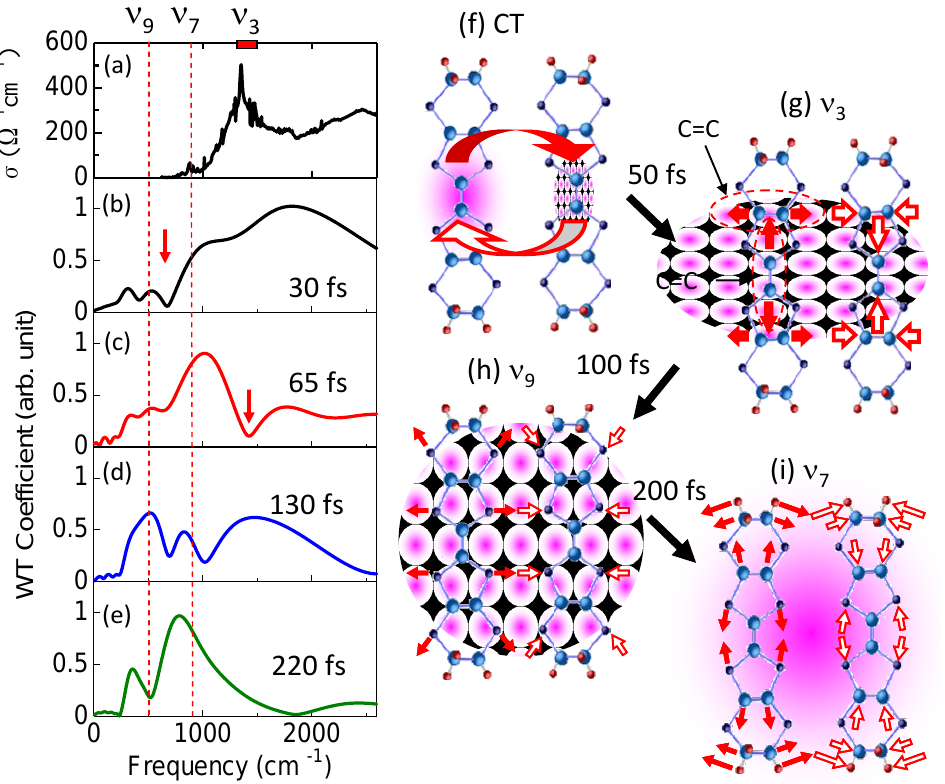
I ; 2 3 , ( h )  , and ( i )  [38]. 3 9 7